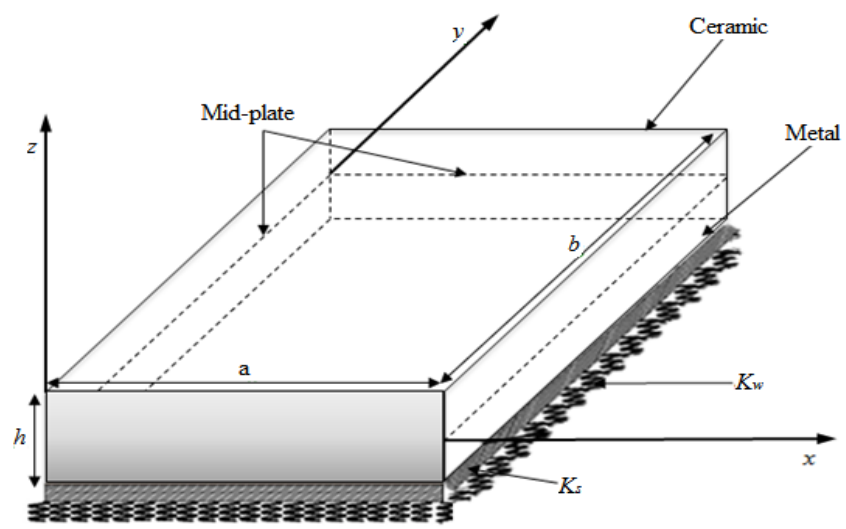
Figure 1. Geometry and coordinates of the considered FGM plate on elastic foundation.